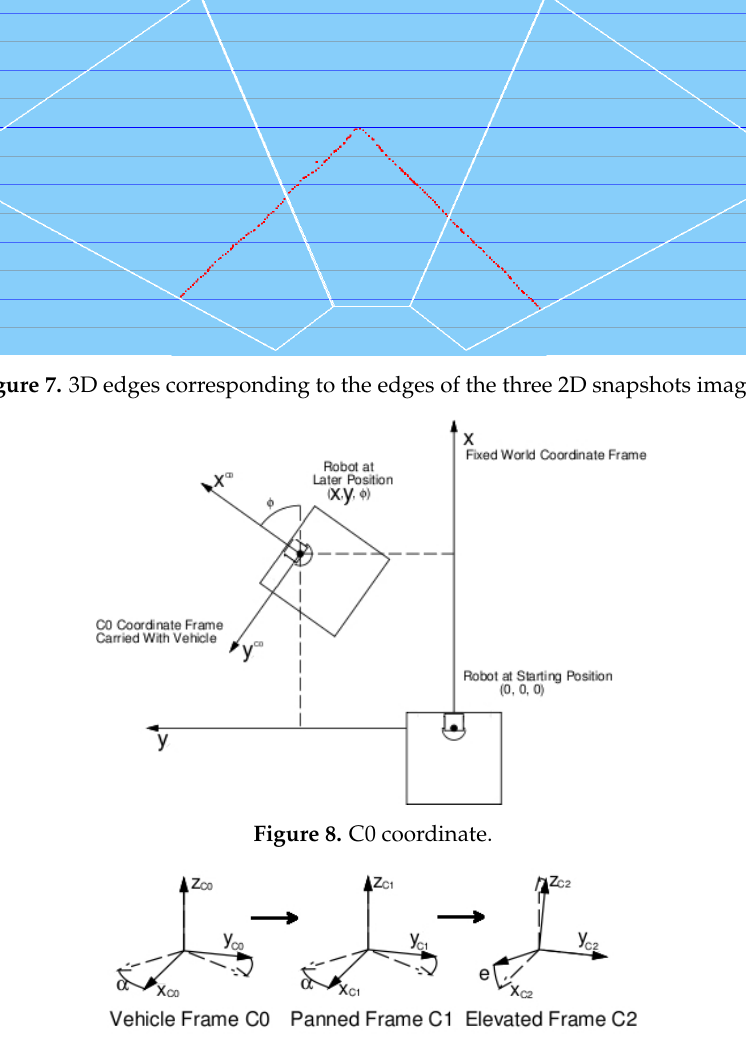
Figure 9. C1 and C2